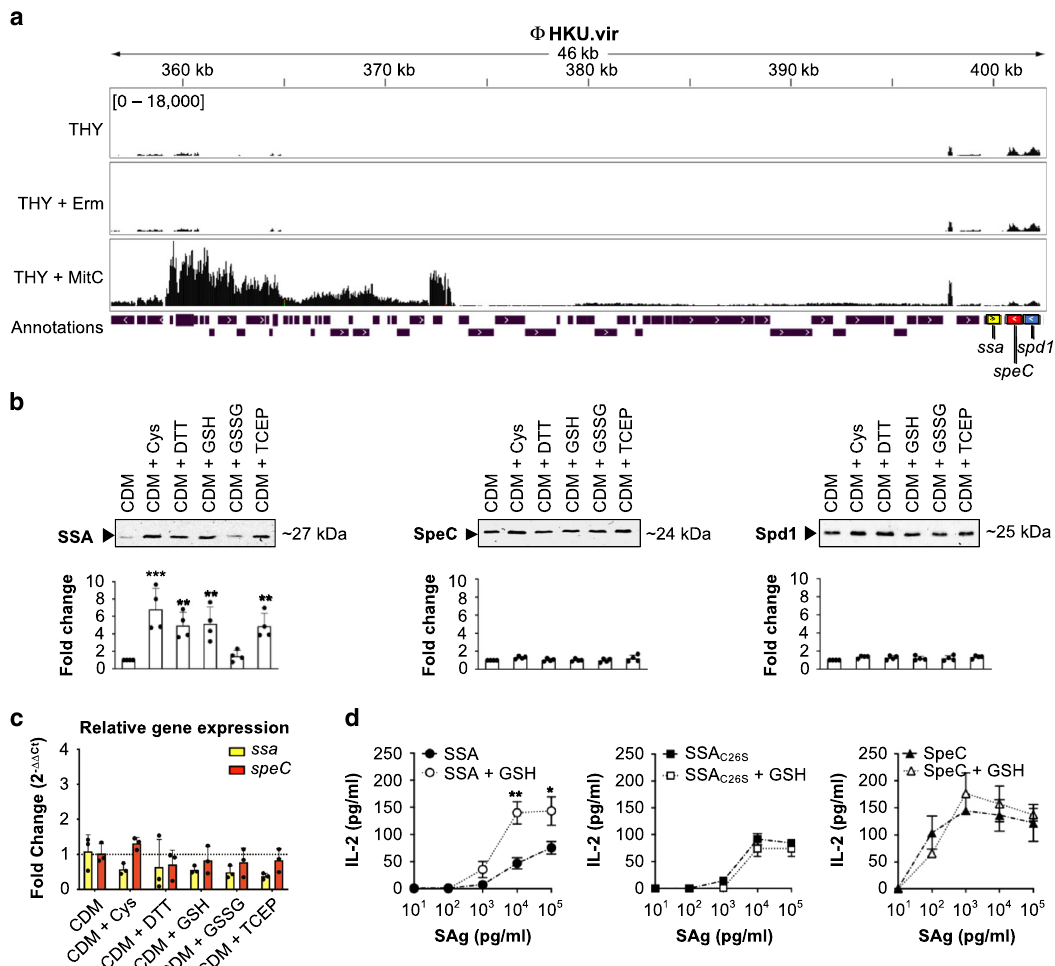
Fig. 1 Post-transcriptional thiol-based regulation of SSA. a RNAseq expression pro fi le of Φ HKU.vir in the macrolide- and tetracycline-resistant GAS emm 12 isolate HKU16, grown in THY broth with sub-inhibitory concentrations of erythromycin (Erm) and mitomycin C (MitC). The plots illustrate the overall coverage distribution displaying the total number of sequenced reads. The region that encodes exotoxin genes ( ssa in yellow, speC in red, and spd1 in blue) is indicated. b Immunoblot detection of SSA, SpeC, and Spd1 in culture supernatants of HKU16 grown in a chemically de fi ned medium (CDM) in the presence of various redox-active compounds. Western blot signal intensities were quanti fi ed with ImageJ. Data are presented as mean values ± SD. Statistical signi fi cance was assessed using one-way ANOVA with Dunnett ’ s multiple comparisons post hoc test against the CDM control group (*** p < 0.001 for CDM + Cys, ** p = 0.008 for CDM + DTT, ** p = 0.006 for CDM + GSH, and ** p = 0.01 for CDM + TCEP) ( n = 4). c Quantitative real-time PCR of ssa and speC transcripts in HKU16 grown in CDM treated with 2 mM of the indicated redox-active compounds. Data from three biological replicates are presented as mean values ± SD. d Superantigen (SAg) activation of human T cells with SSA (circular), SSA C26S (square), and SpeC (triangular) at the indicated concentrations in absence (black; dash-dot line) or presence of 2 mM of GSH (white; dotted line), using human IL-2 as a readout. Results are expressed as the mean ± SEM from three independent experiments from one representative donor (out of three independent donors). Statistical signi fi cance was assessed by two-tailed unpaired Student ’ s t test (** p = 0.0062 for SSA + GSH at a Sag concentration of 10 4 pgmL − 1 , and * p = 0.0306 for SSA + GSH at a Sag concentration of 10 5 pg mL − 1 ). Source data are provided as a Source Data fi